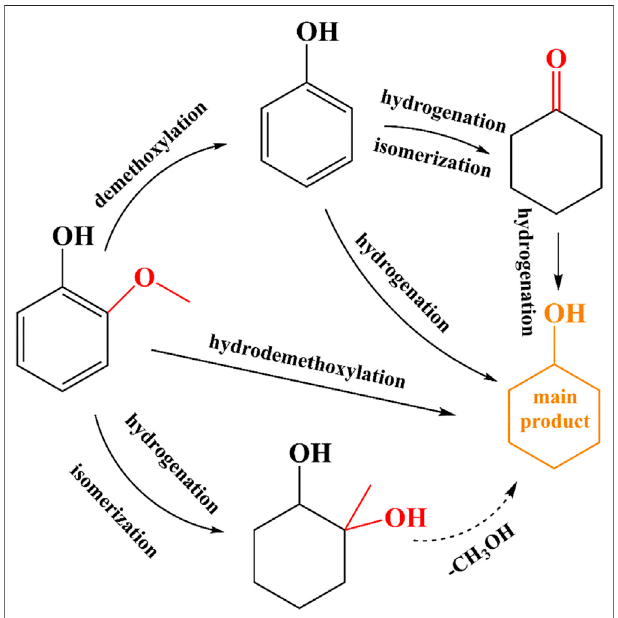
FIGURE 8 | Possible reaction pathway for the conversion of guaiacol over Ni – Mn/Nb 2 O 5 .